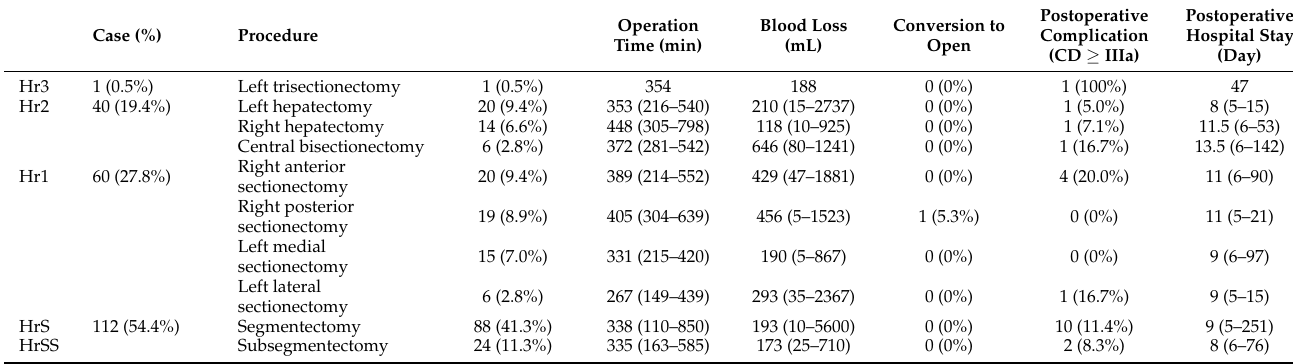
Table 2. Types of surgical procedure and surgical